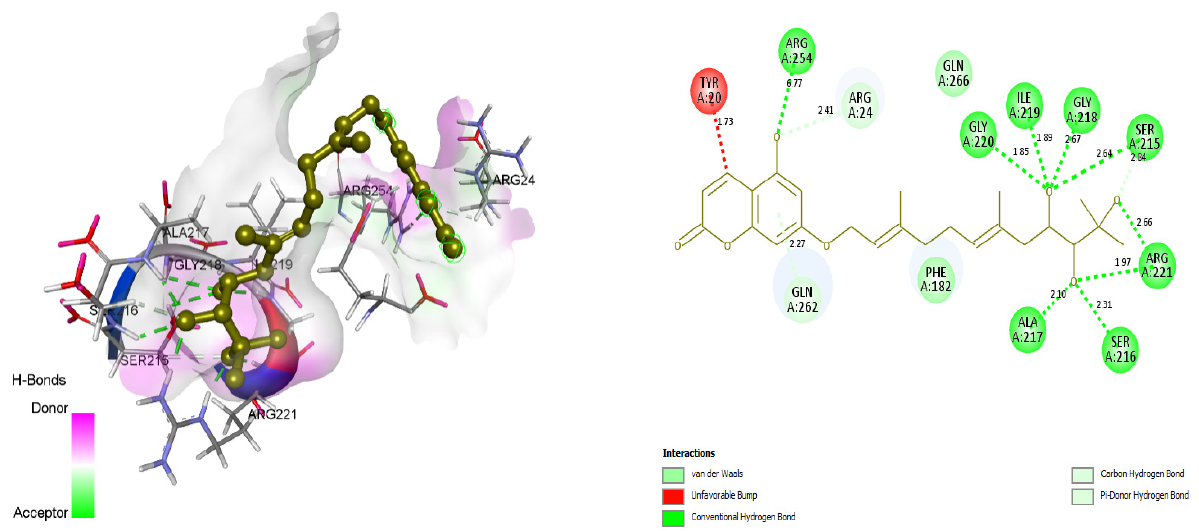
Figure 5. Docking view of ZINC31168041in the binding sites of PTP1B (PDB ID: 1AAX). On the left side is the stereo view of the docked complex-ZINC31168041 and 1AAX, on the right side, ZINC31168041-1AAX interactions are presented in 2D view. Diagrams are drawn in Discovery Studio, hydrogen-bonds are shown as agreen-dashed line along with the distance in Å. Protein structure residues are annotated with a 3-letter amino acid code, while ZINC31168041 is presented in agreen-colored ball and stick style.